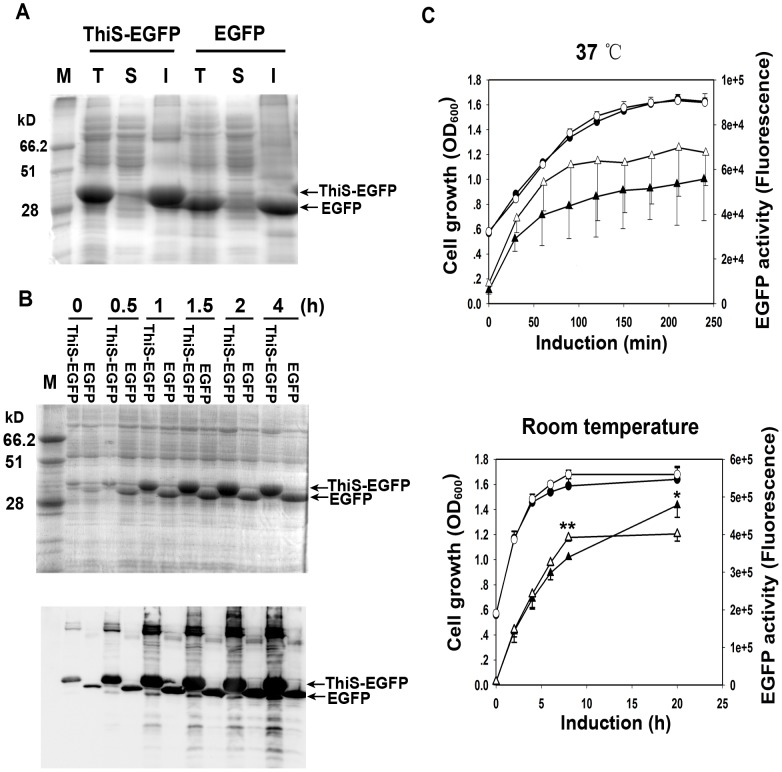
Enhanced expression of EGFP fused with ThiS.(A) The recombinant EGFP proteins without (EGFP) or with ThiS-tag (ThiS-EGFP) fused at C-terminus, were induced by 1 mM IPTG for 4 h at 37°C. Total cell lysate (T) and the soluble (S) or insoluble (I) fraction were resolved on 12% SDS-PAGE. Expressed proteins are highlighted by arrows. (B) Expression in total cell lysate from cells at different time after IPTG induction at 37°C were analyzed on 12% SDS-PAGE (upper panel) and immunoblot (lower panel). (C) Cell growth (open circle for EGFP, solid circle for ThiS-EGFP) was recorded by measuring absorbance at 600 nm; the fluorescence of expressed products (open triangle for EGFP, solid triangle for ThiS-EGFP) was measured (excitation 488 nm; emission 509 nm), on different time point after induction by IPTG, for 4 hours at 37°C (the upper panel) or for 20 hours at room temperature (25°C, the lower panel). Each point represents mean and SD of 3 independent experiments. *P<0.05; **P<0.01.